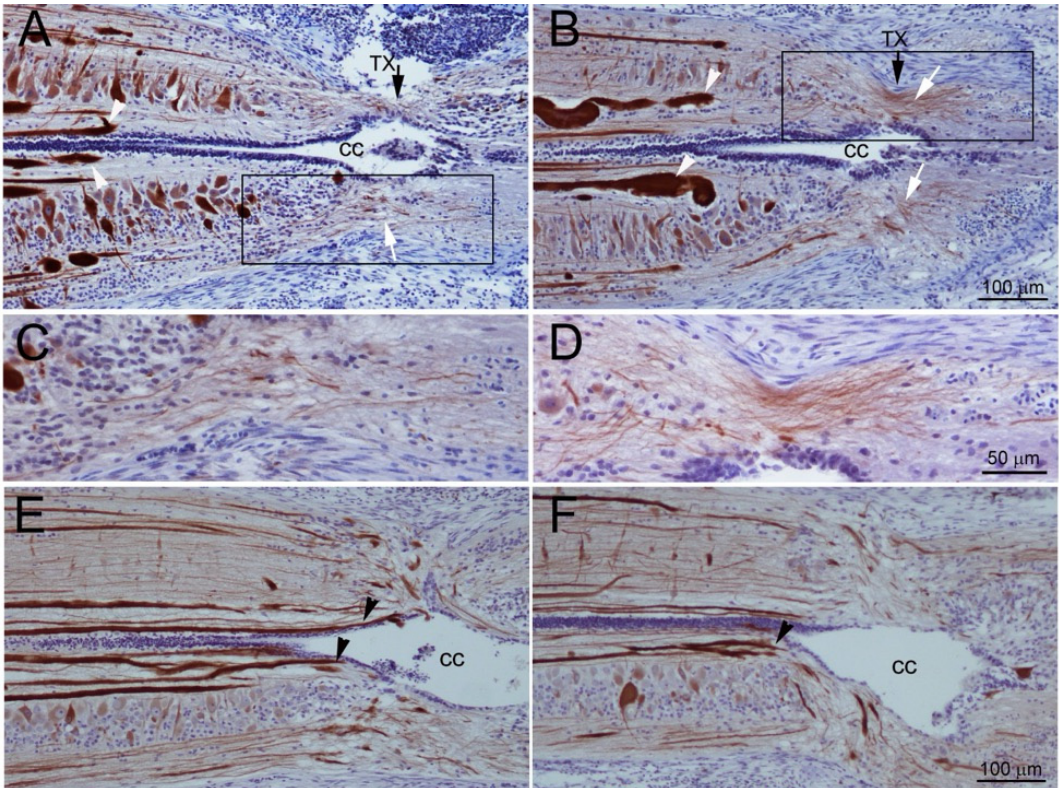
Figure 1. Early regeneration of small-caliber axons across the transection (TX) site. ( A ) and (B ) , horizontal sections spanning the TX site (black arrows) from two different lampreys at 2 weeks post-TX, stained with an antibody (LCM3) to lamprey NF and conterstained with hematoxylin. Black arrows point to the TX site. The central canal (cc) is expanded and the SC is narrowed, and surrounded by connective tissue. Many fine axons (white arrows) bridge the lesion, but giant reticulospinal (RS) axons have retracted and have not regenerated back to the TX site (white arrowheads). ( C ) and ( D ), enlarged images from the boxed areas in ( A ) and ( B ), respectively. ( E ) and ( F ), horizontal sections from two SCs at 4 weeks post-TX, showing that some giant RS axons have regenerated within the proximal stump and into the lesion (black arrowheads). Thus, there are small axons bridging the lesion by 2 weeks post-TX, while large axons have only just grown back to the injury site by 4 weeks.